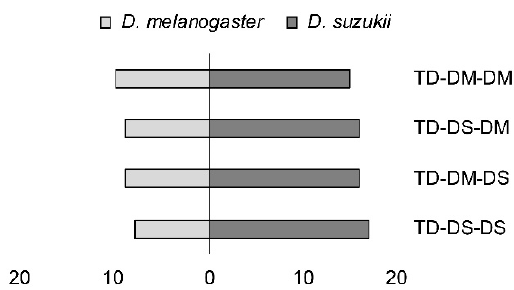
Figure 4. First host choice, measured as stinging into a host pupa by females from two strains of Trichopria drosophilae that were reared for > 30 generations either on D. melanogaster or on D. suzukii . T. drosophilae parasitoids (TD) were reared on either D. melanogaster (DM) or D. suzukii (DS), and were then allowed one passage through either host (DM or DS) in the generation prior to the experiment.